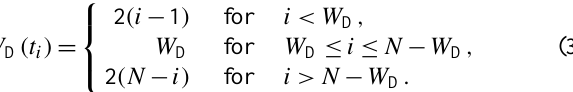
Fig. 2. Plio-Pleistocene variability of (A) δ 18 O at ODP site 659 (Tiedemann et al., 1994), and of terrigenous dust flux from North Africa at ODP sites (B) 659 (Tiedemann et al., 1994), (C) 721/722 (deMenocal, 1995, 2004), and (D) 967 (Larrasoa˜na et al., 2003). The horizontal red bars in panel (A) indicate two consecutive recur- rence windows of length W ∗ = 410 kyr and mutual offset ∆ W ∗ = 41 kyr as used in the analysis of Sec. 4 and in Figs. 9–12.